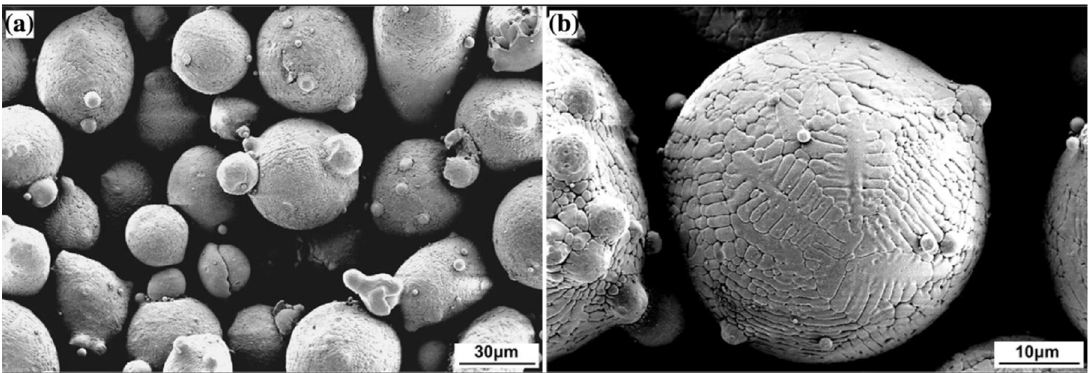
Figure 12. SEM image of HEA particles produced through gas atomisation ( a ) spherical morphology and satellite particles, and ( b ) dendritic structure visible at high magnification. Reprinted with permission from [139] Copyright 2019 Elsevier.